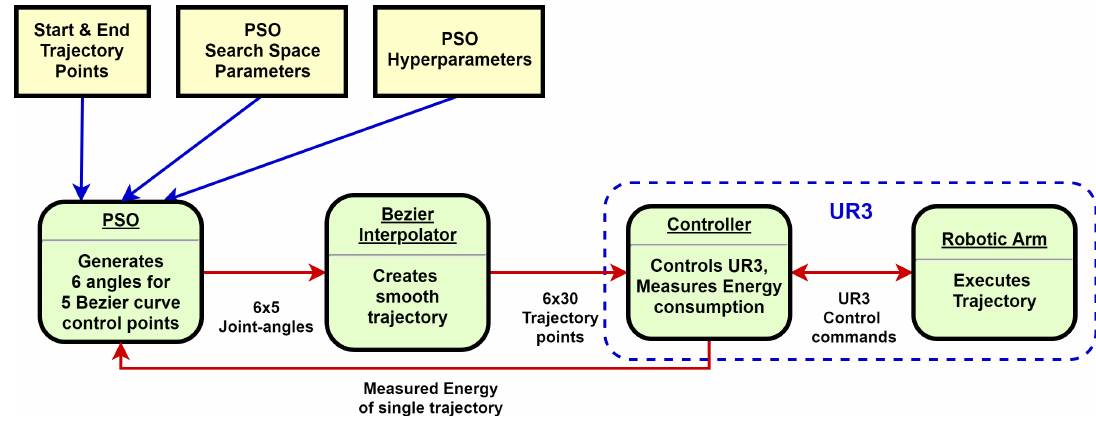
Figure 2. Block diagram of the proposed